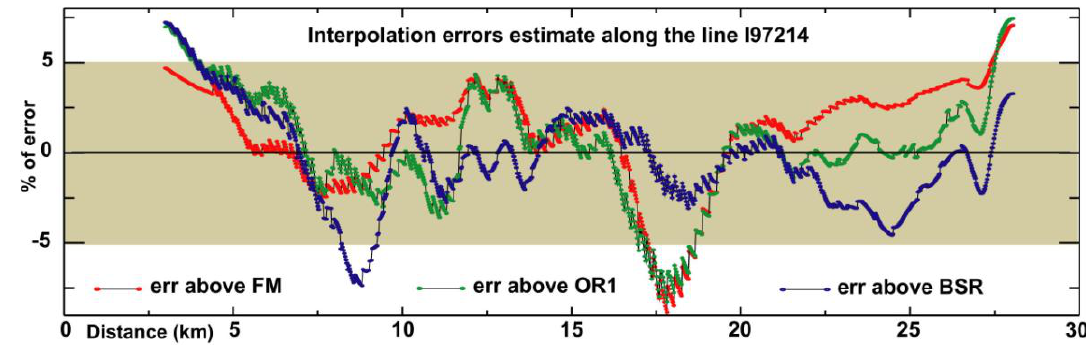
Figure 2. Percentage error of the interpolated velocities along the line I97214 at the sea floor (SF, stars), the horizon 1 (HOR1; solid triangles), and the BSR (crosses). See text for